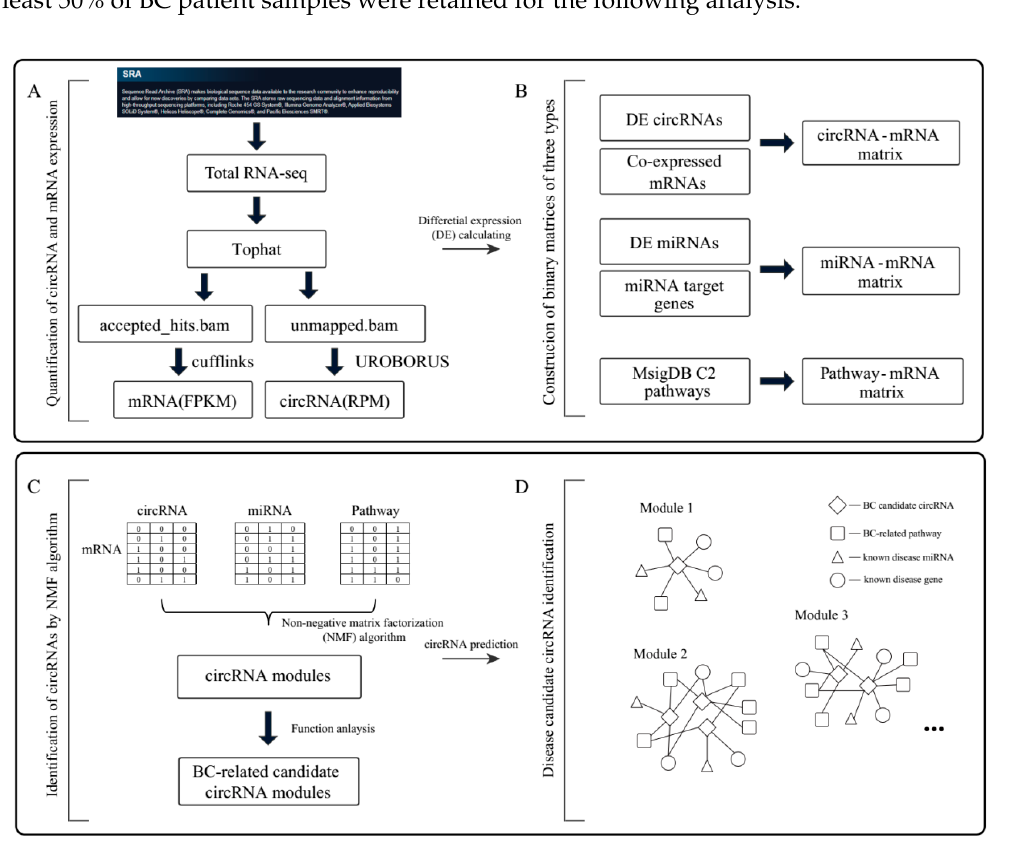
Figure 1. The flowchart of identification of breast cancer (BC)-related circRNA modules. The flowchart depicted a summary of the most important steps of the analysis workflow.